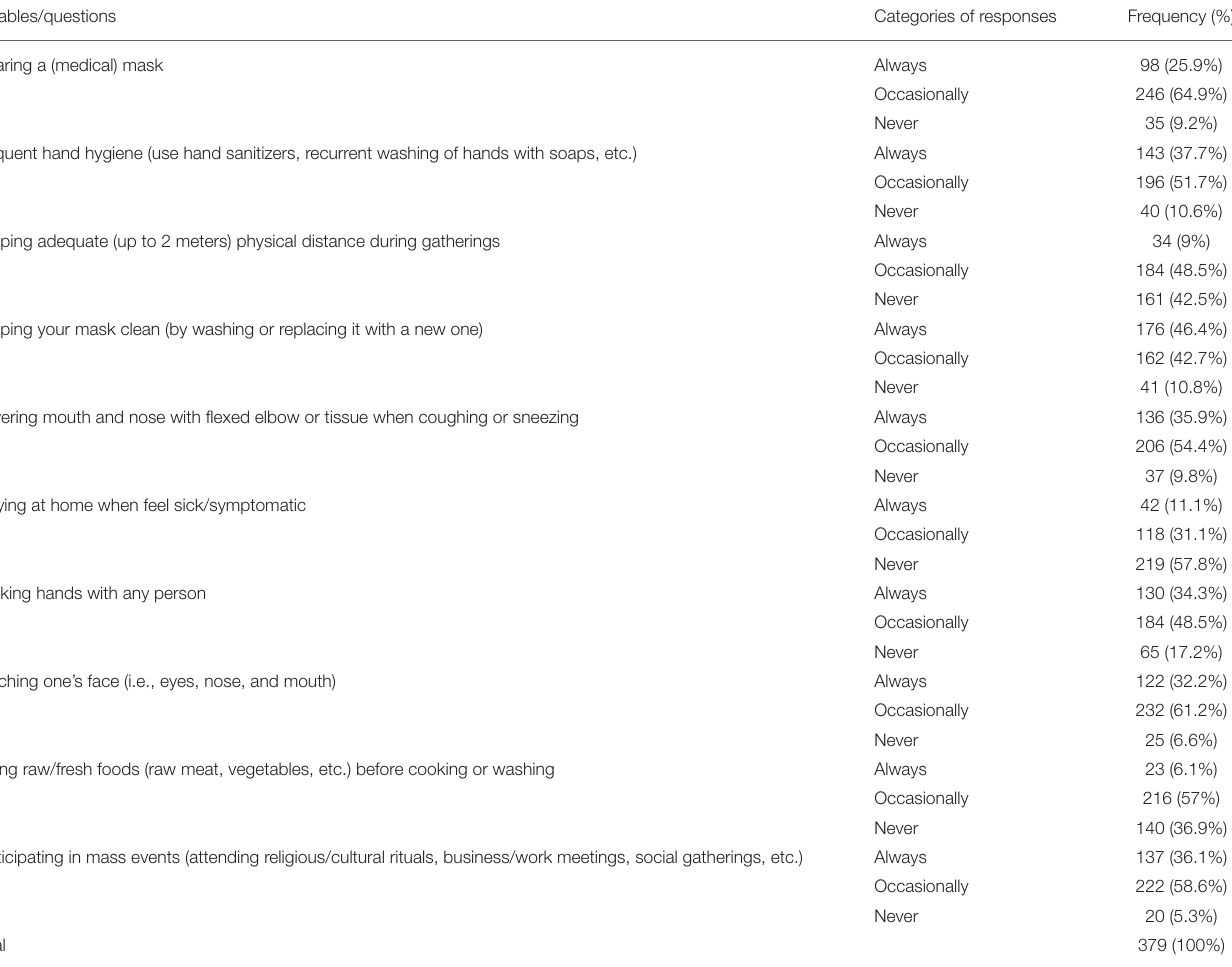
TABLE 4 | Extent of practices and compliances with the major protective behavioral